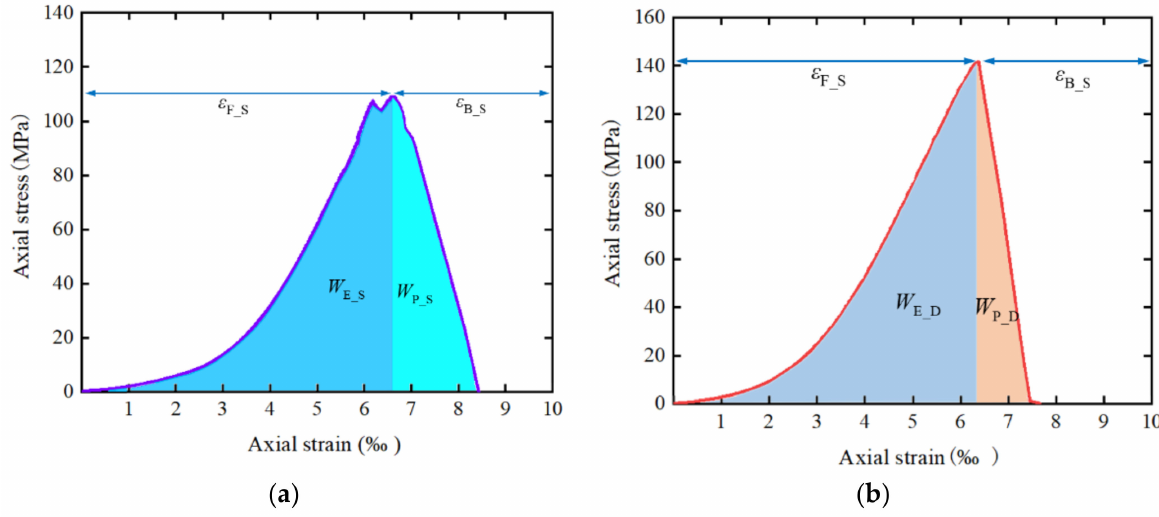
Figure 5. Stress–strain curves of granite specimen: ( a ) Entrance section; ( b ) Deep buried